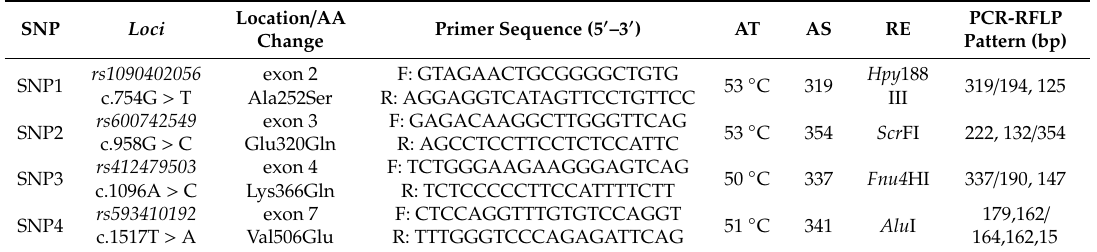
Table 1. Polymerase chain reaction-restriction fragment length polymorphism (PCR-RFLP) conditions for the analysed single nucleotide polymorphisms (SNPs) in the SLC27A3 gene and information on the loci and substitution of amino